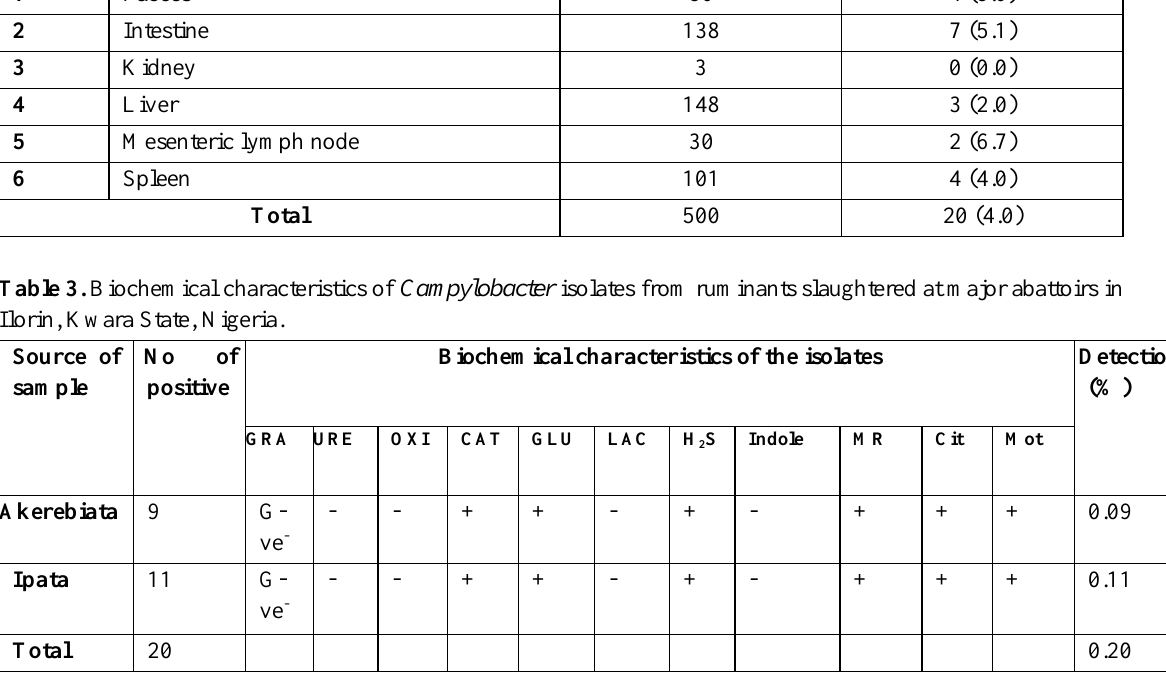
Key: GRA= Gram reactions, G-ve - =Gram negative rods, URE=urease, OXD=oxidase, CAT=catalase, GLU=glucose, LAC=lactose, - =negative, +=positive H Table 4. Antimicrobial susceptibility profiles of Salmonella isolates from ruminants slaughtered at the two major abattoirs in Ilorin, Kwara